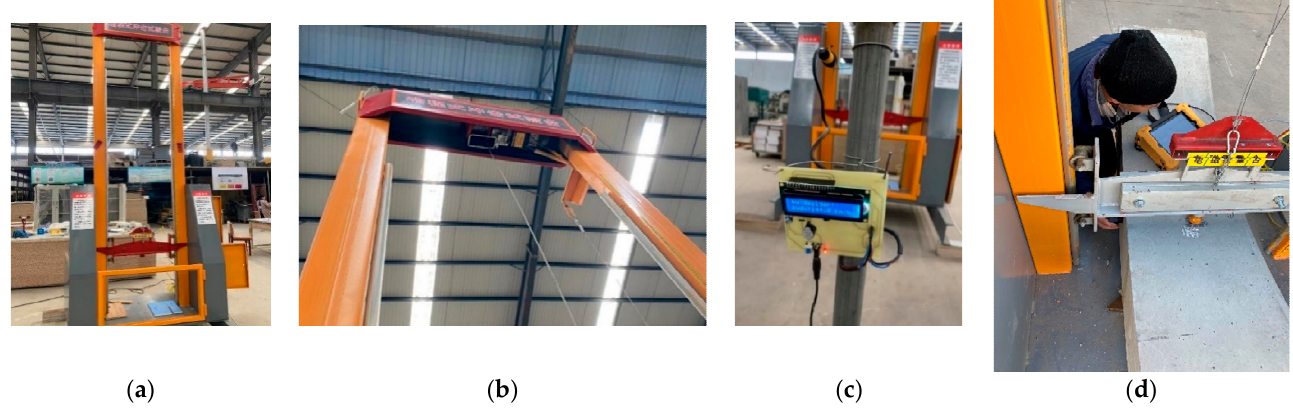
Figure 10. The drop-weight-impact system: the steel frame ( a ); the hoister ( b ); the drop-speed monitor ( c ); the drop weight ( d ).